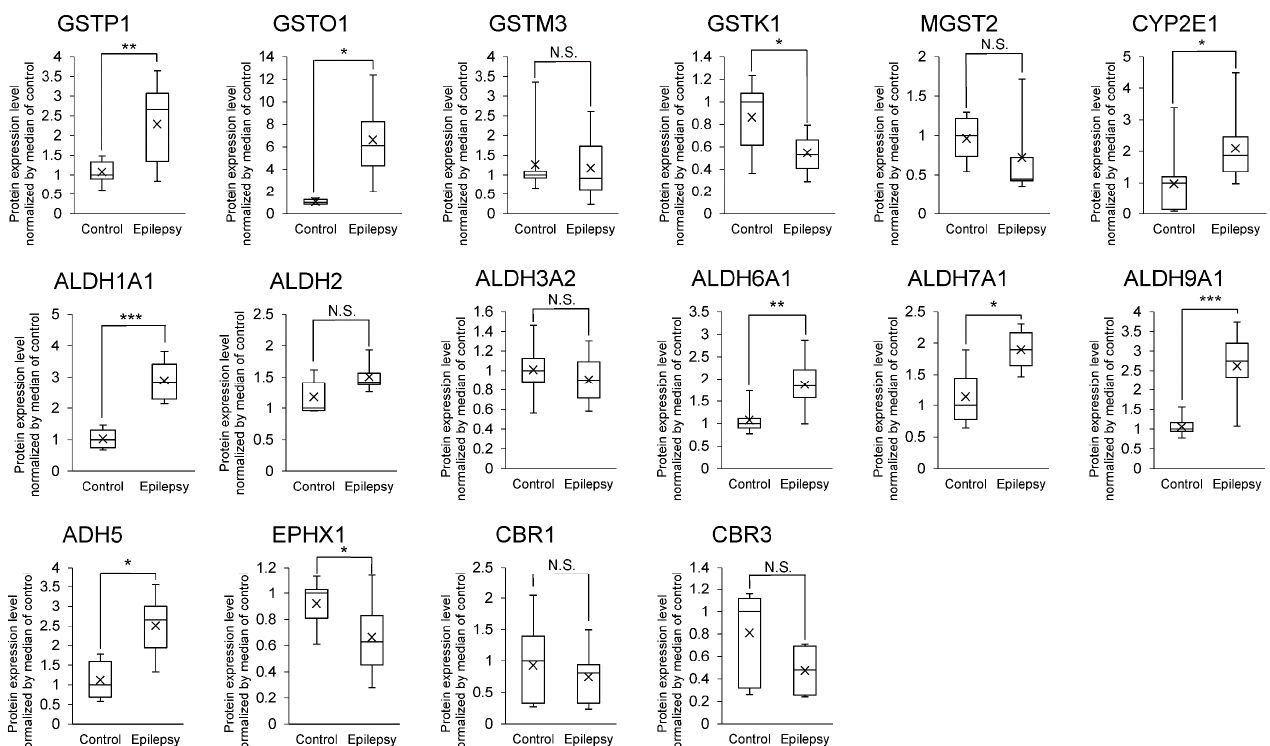
Figure 2. Protein expression level of AED-metabolizing enzymes in epileptic brain capillaries compared to controls. Brain capillaries were isolated from focal sites in six epilepsy patients and five normal brains; tryptic digests were produced and subjected to SWATH analysis. The band inside the box represents the median, and the bottom and top of the box indicate the first and third quartiles, respectively. The whiskers indicate the minimum and maximum values for the protein levels. X plots show the average in each group. The data are normalized by the median of the protein expression level in controls. * BH-adjusted p value < 0.05, ** BH-adjusted p value < 0.01 and *** BH-adjusted p value < 0.001, significantly different between the epilepsy and control groups. N.S., not significantly different. GSTP1, Glutathione S-transferase pi; GSTO1,